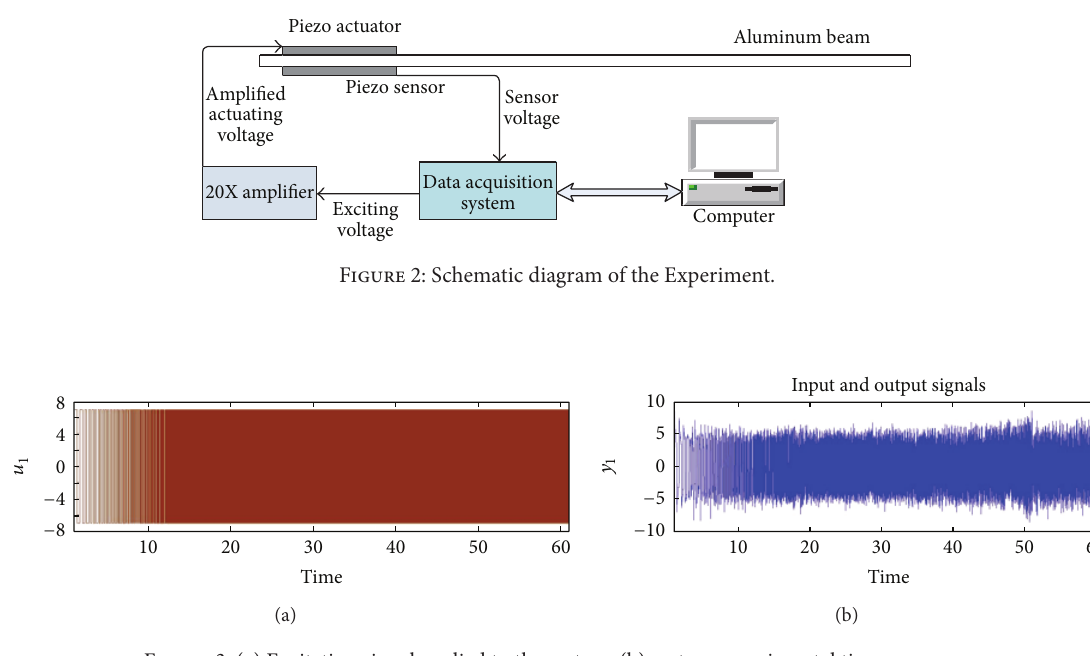
Figure 3: (a) Excitation signal applied to the system; (b) system experimental time